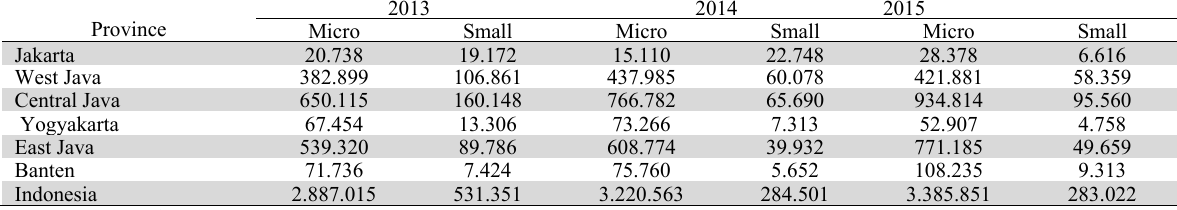
Number of Micro and Small Business Units in Java Island 2013-2015